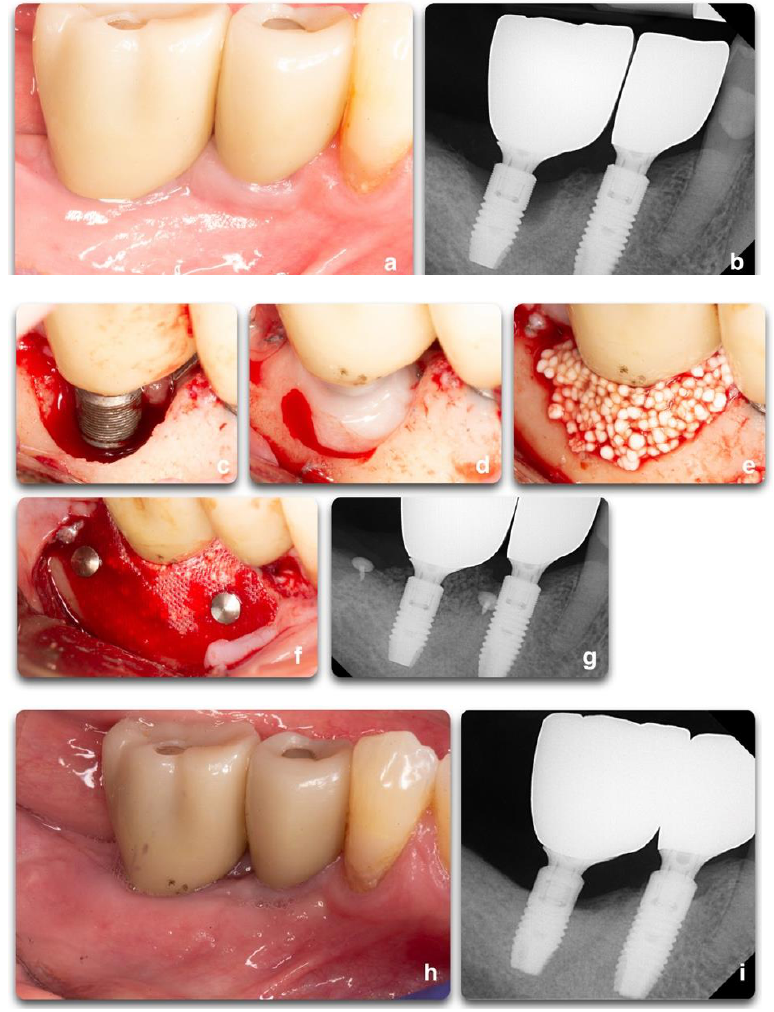
Figure 9. Regenerative peri-implant therapy for implant area #31. ( a , b ) Pre-operative clinical and radiographic presentation. BoP, SUP, PD 10mm. ( c ) Defect configuration after the elevation of the full-thickness flap on implant #31. ( d ) Implant surface decontamination with rotating titanium brushes, saline and chlorhexidine rinse, and the application of PrefGel ® 24% EDTA (2021 Institut Straumann AG ® ). ( e , f ) Bone grafting application (GUIDOR ® easy-graft ® CLASSIC Alloplastic Bone Grafting System © © Copyright Collagen Matrix, Inc — Allendale, NJ, USA), covered by the GUIDOR ® matrix barrier membrane, and stabilized by two titanium tacks. ( g ) Radiograph showing the grafting material at the time of surgery completion. ( h , i ) 13 months post-operative clinical and radiographic outcomes. Partial fill of the intra-bony defect with a residual supra-crestal defect.